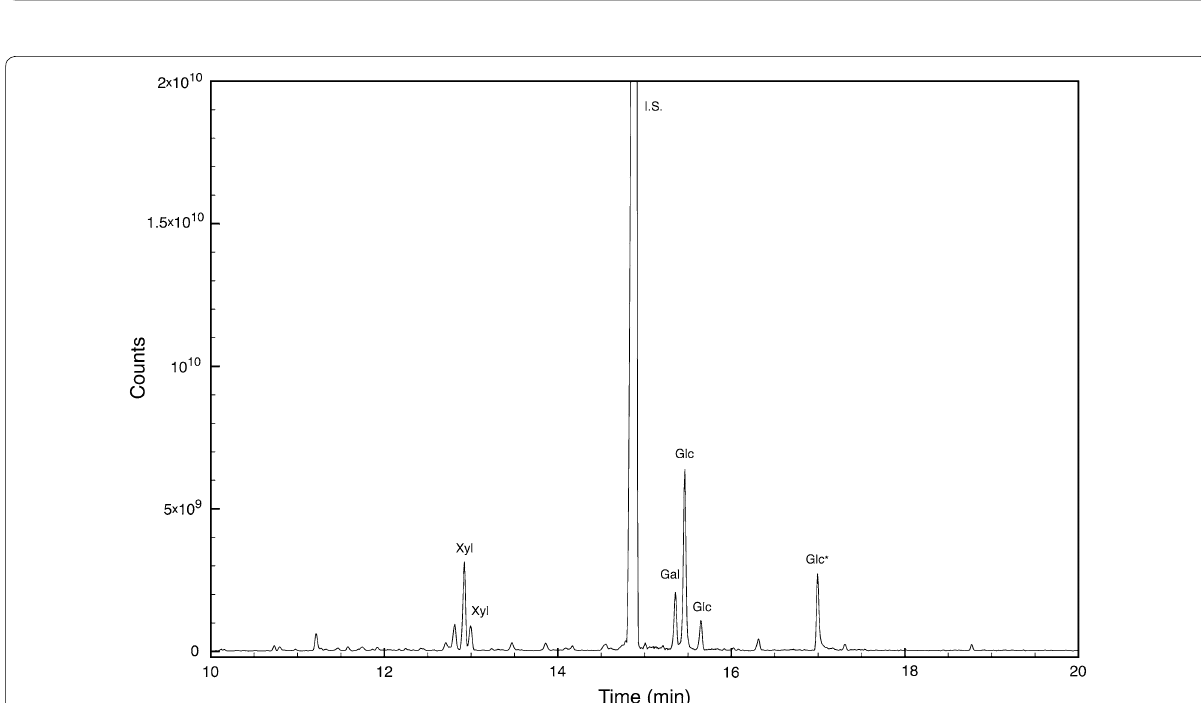
Fig. 7 Surface tension measurements with pendant drop tensiometry: grayscale image, drop data and resulting surface tension of supernatants of P. septica OOWS-10 ( a ) and P. septica OOYS-10 ( b )